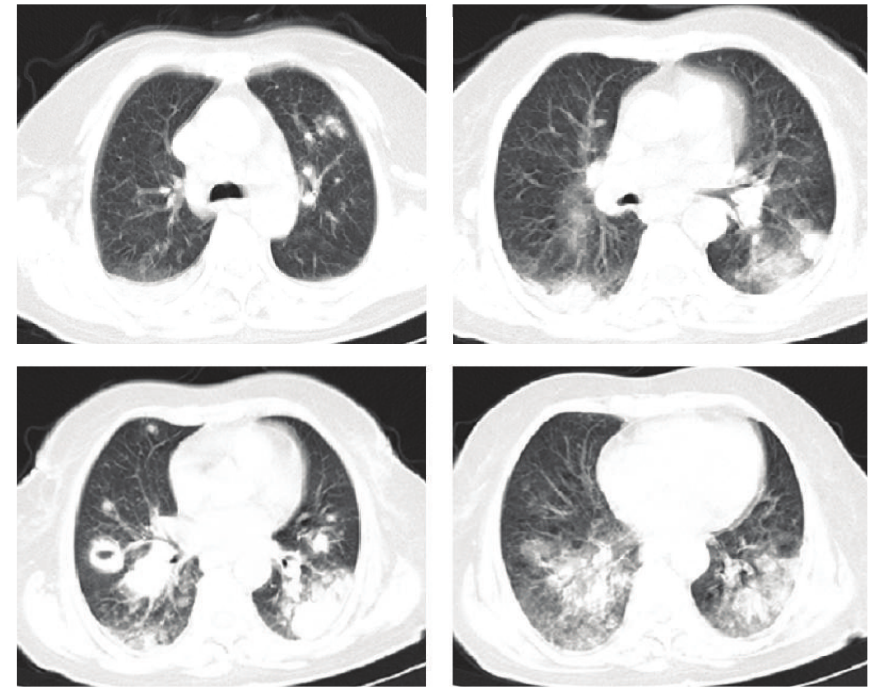
Figure 2: Parenchymal window of computed tomography scan showing parenchymal nodules, infiltrations, pleural masses, and cavitary